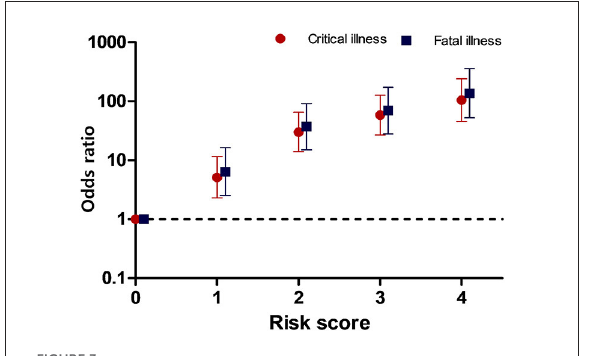
FIGURE3 Odds ratios for critical and fatal illness according to the risk score. The scores represent the number of risk